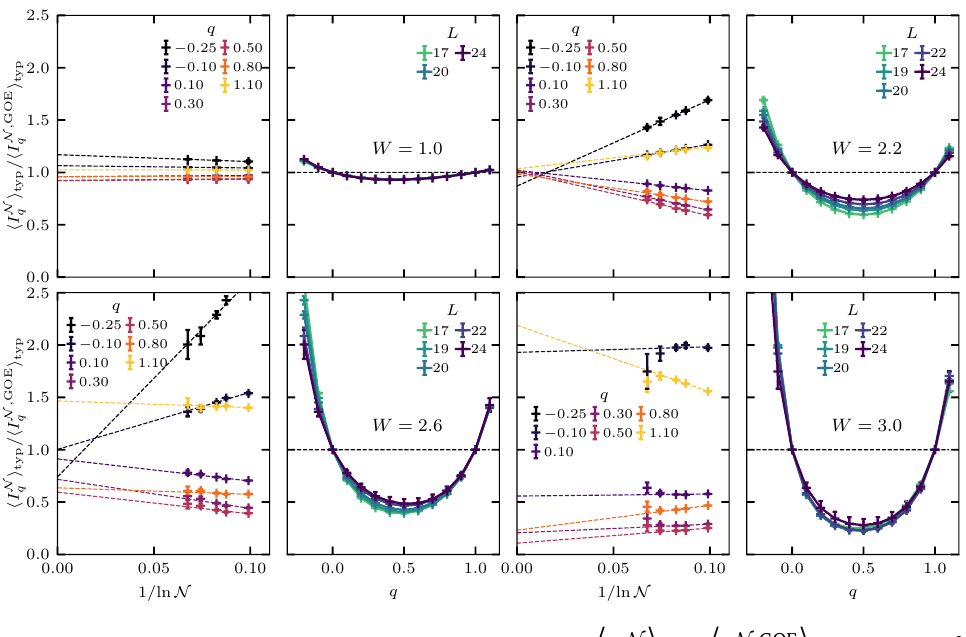
Figure 5: Odd columns. Finite size data of the ratio, for a number of q -s and disorder strength W (see legend). Dashed lines are extrap- olation to N → ∞ . Even columns . The same ratio function of q . Dashed black line indicates GOE